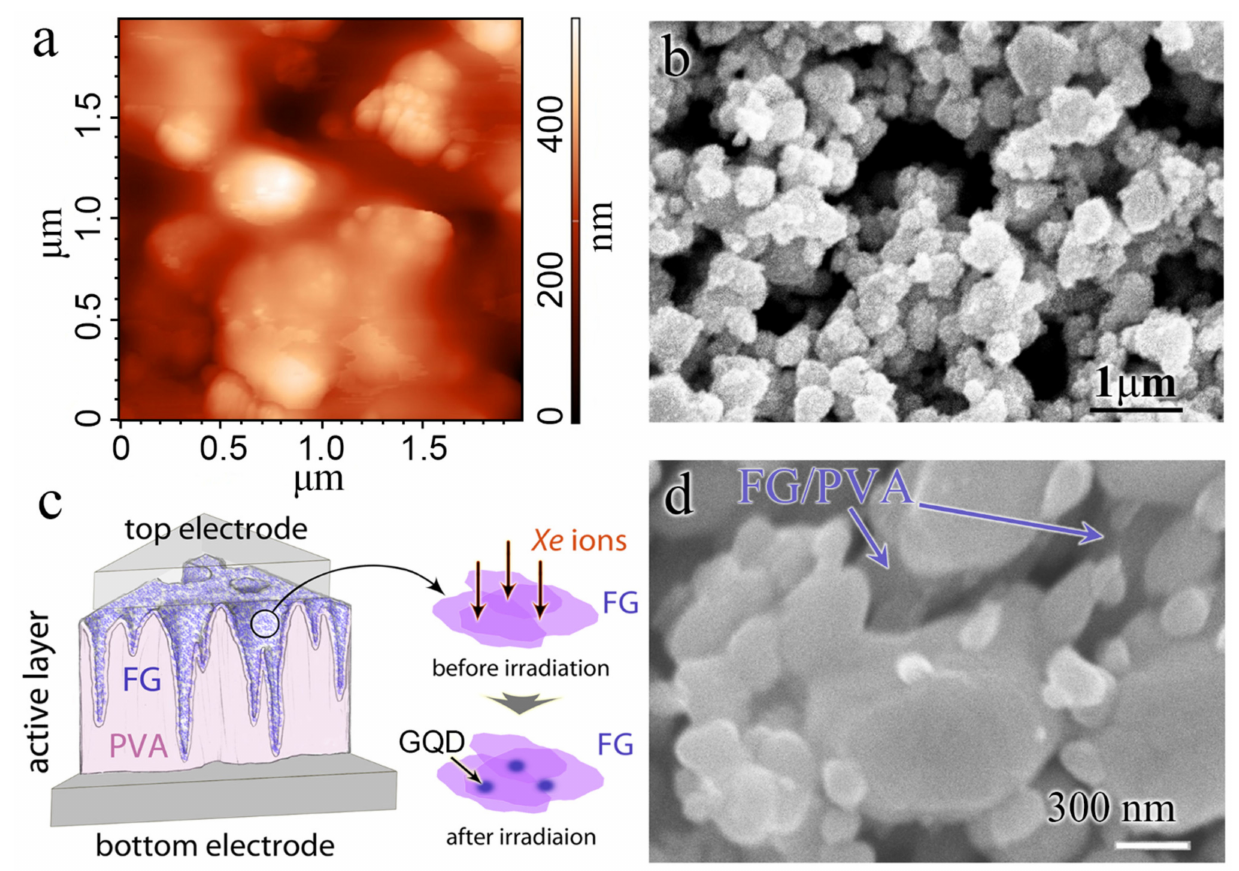
Figure 2. ( a ) AFM image of active FG–PVA layer of the crossbar structures on the Si substrate before irradiation. ( b ) SEM image of active FG–PVA layer of the crossbar structures on the Ag printed layer before irradiation ( c ) Sketch of the active FG–PVA layer in the crossbar structures and the formation of the GQD after high energy ion irradiation. ( d ) SEM image of active FG–PVA layer of the crossbar